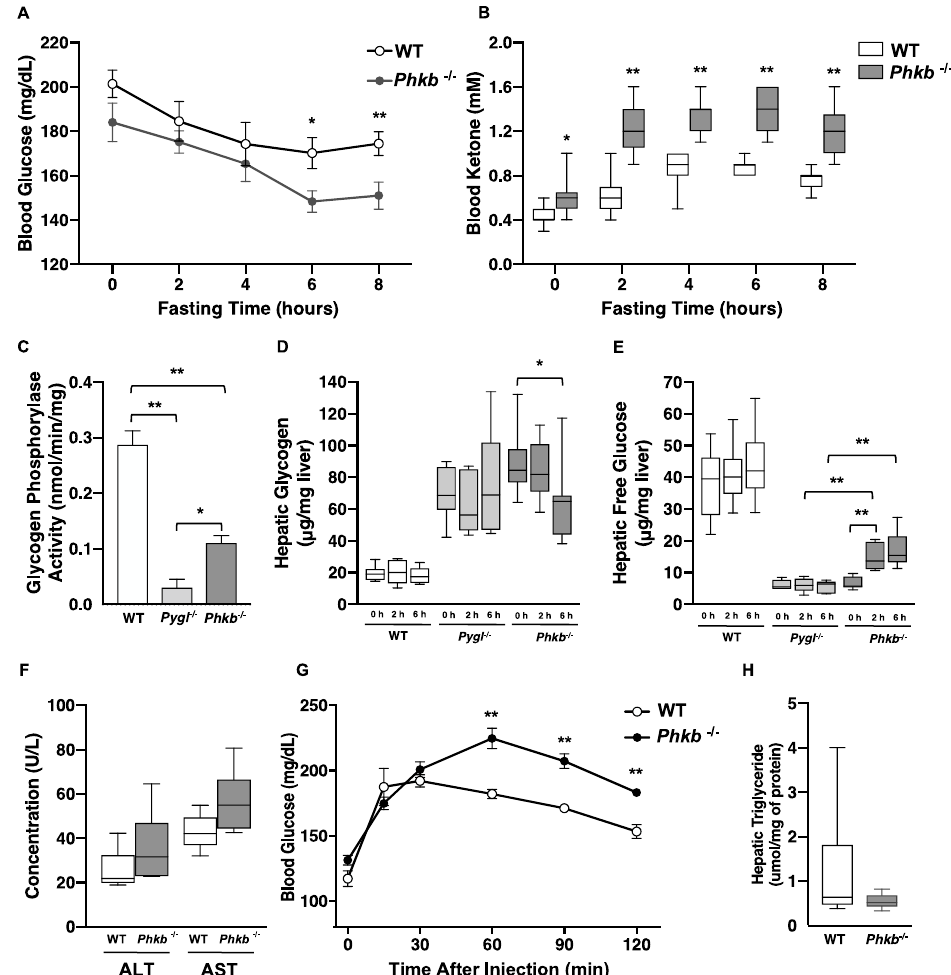
Figure 2. Phenotypical analysis of Phkb − / − mice. ( A ) Fasting glucose and ( B ) ketone tests were performed in (WT, n = 11, Phkb − / − , n = 9) mice. Blood glucose and ketone (Beta-hydroxybutyrate) levels were measured at 0, 2, 4, 6, and 8 h intervals; Mean blood glucose (mg/dL) in Phkb − / − mice (black dots) showed reduced baseline (0 h) blood glucose levels and significantly lower blood glucose levels at 6 (* p < 0.05) and 8 (** p < 0.01) hour intervals. WT (white dot) maintained blood glucose levels >160 mg/dL through fasting; fasting in Phkb − / − mice revealed significantly elevated ketone bodies (mM) at baseline (0 h, * p < 0.05) and at all fasting intervals (0 h; * p < 0.05, 2 h, 4 h, 6 h, and 8 h; ** p < 0.01 compared to WT mice. ( C ) Enzymatic activity of glycogen phosphorylase (PYGL) in wild-type (n = 6; WT, white bar), Pygl − / − (n = 6, light grey bar) and Phkb − / − (n = 6, grey bar) mice. ( D ) Hepatic glycogen and ( E ) free glucose levels at 0 h, 2 h, and 6 h of fasted WT (0 h, n = 11, 2 h, n = 13, and 6 h, n = 13), Pygl − / − (0 h, n = 7, 2 h, n = 5, and 6 h, n = 5), and Phkb − / − (0 h, n = 9, 2 h, n = 6, and 6 h, n = 7) mice. ( F ) Serum levels of ALT, AST in WT (n = 7) and Phkb − / − (n = 7) mice. ( G ) Pyruvate tolerance test for WT and Phkb − / − mice with mean blood glucose levels in mice (WT, n = 9 and Phkb − / − n = 6) through time intervals following pyruvate bolus injection (2.0 g/kg) after 16 h of fasting (0 h). ( H ) Hepatic triglyceride contents in WT (n = 9) and Phkb − / − (n = 10) mice. Fasting blood ketone, hepatic glycogen, hepatic free glucose, ALT, AST, and TG data shown as box and whisker plot, Min to Max. Fasting glucose levels and pyruvate tolerance test are expressed as the mean ± SEM. * p < 0.05 and ** p < 0.01.